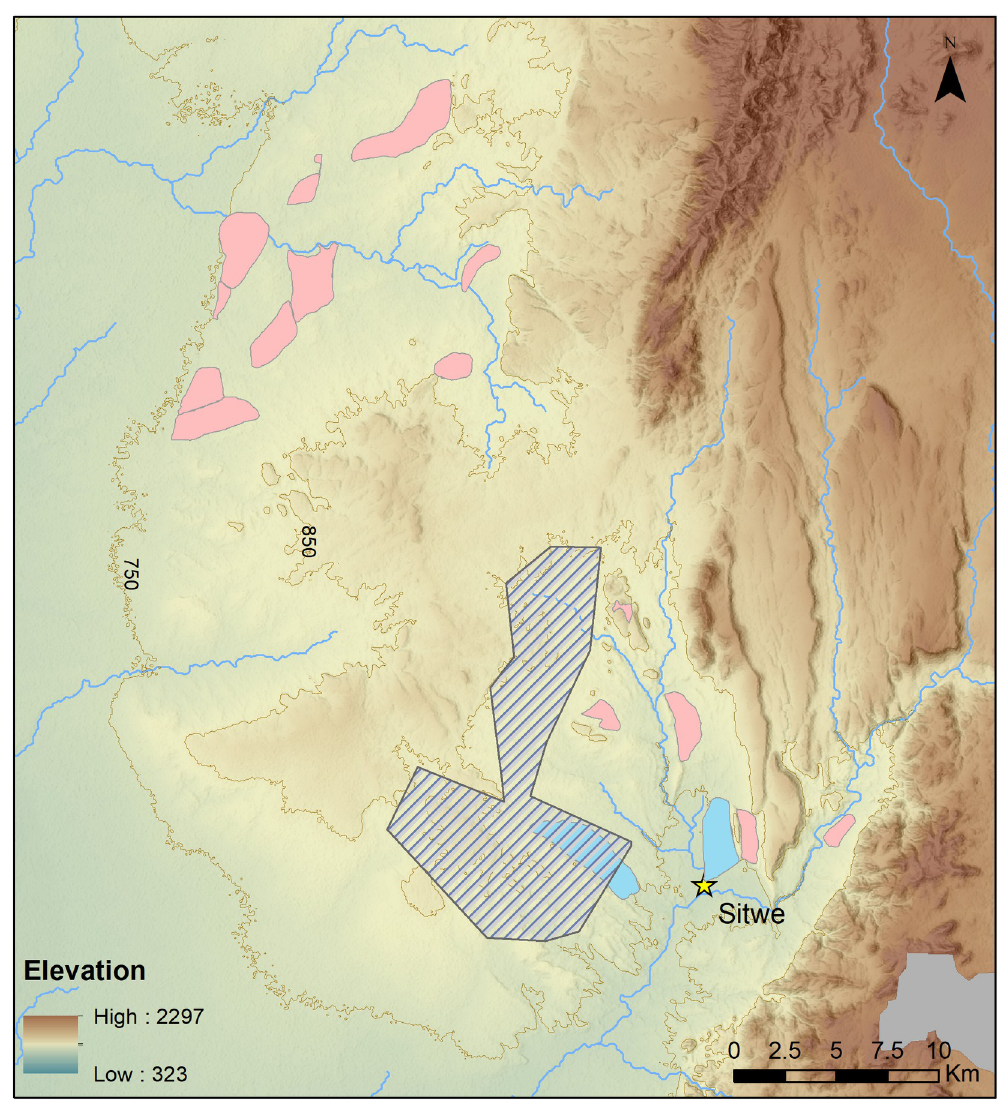
Resources Observatory and Science (EROS) Center) (public domain):